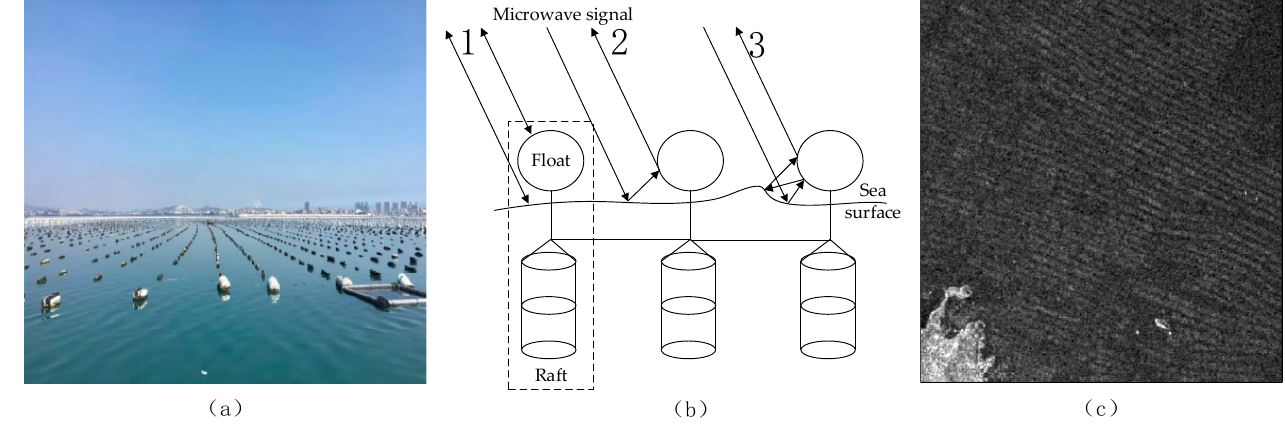
Figure 1. View of the marine raft aquaculture area: ( a ) natural image of the marine raft aquaculture area (http://www.shuichan.cc/news_view-397141.html, (accessed on 21 February 2020); ( b ) description of the scattering principle of floating raft in the marine raft aquaculture area. 1. Surface scattering from the seawater and the floats; 2. Double-bounce scattering from seawater and floating balls; 3. Helix scattering from seawater and floats; ( c ) marine raft aquaculture areas in Sentinel-1 image .